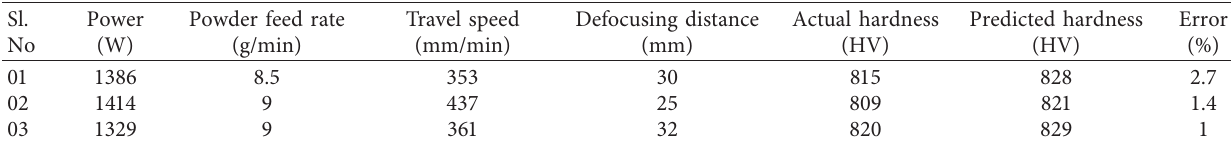
Figure 3: Microhardness and weight loss with error bar for all thirty experiments. Table 6: Verification results for microhardness.